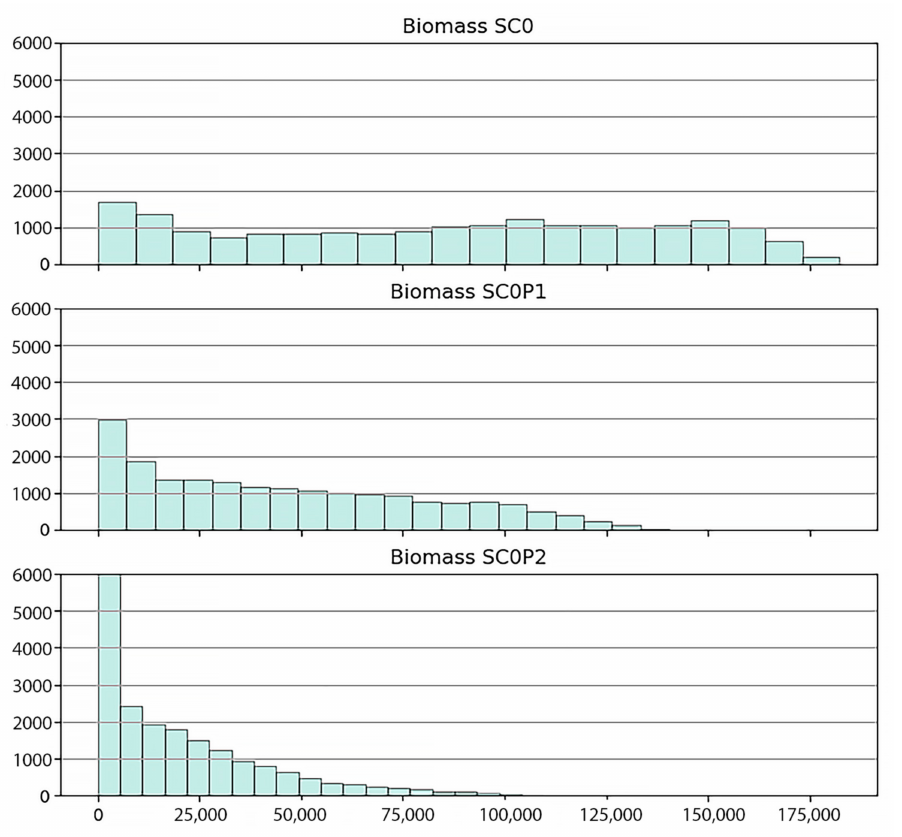
Figure 9. Biomass (kg / ha) histogram of three scenarios in the last phase of simulations (in